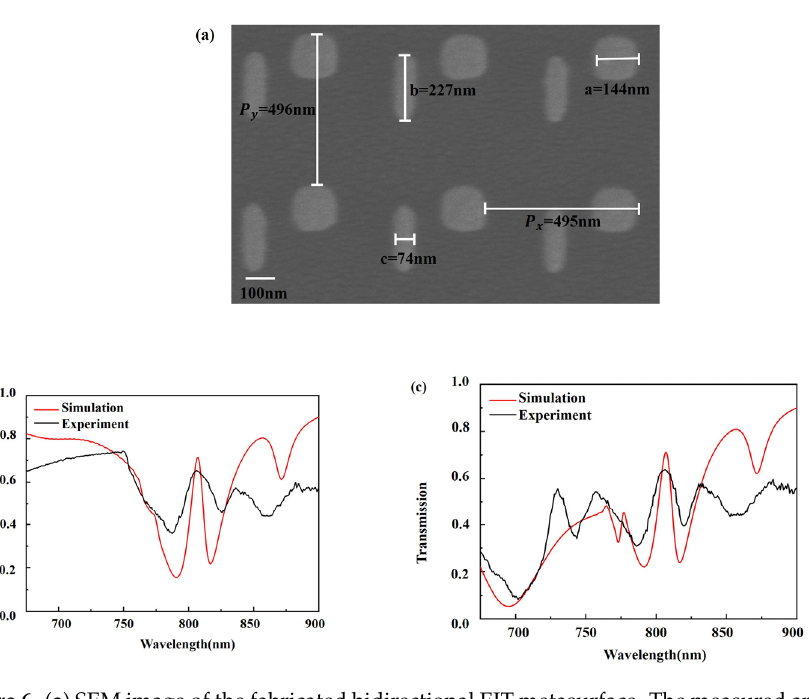
Figure 6. ( a ) SEM image of the fabricated bidirectional EIT metasurface. The measured and simulated transmission spectrum of the bidirectional EIT metasurface ( b ) under forward incidence, ( c ) under backward incidence.